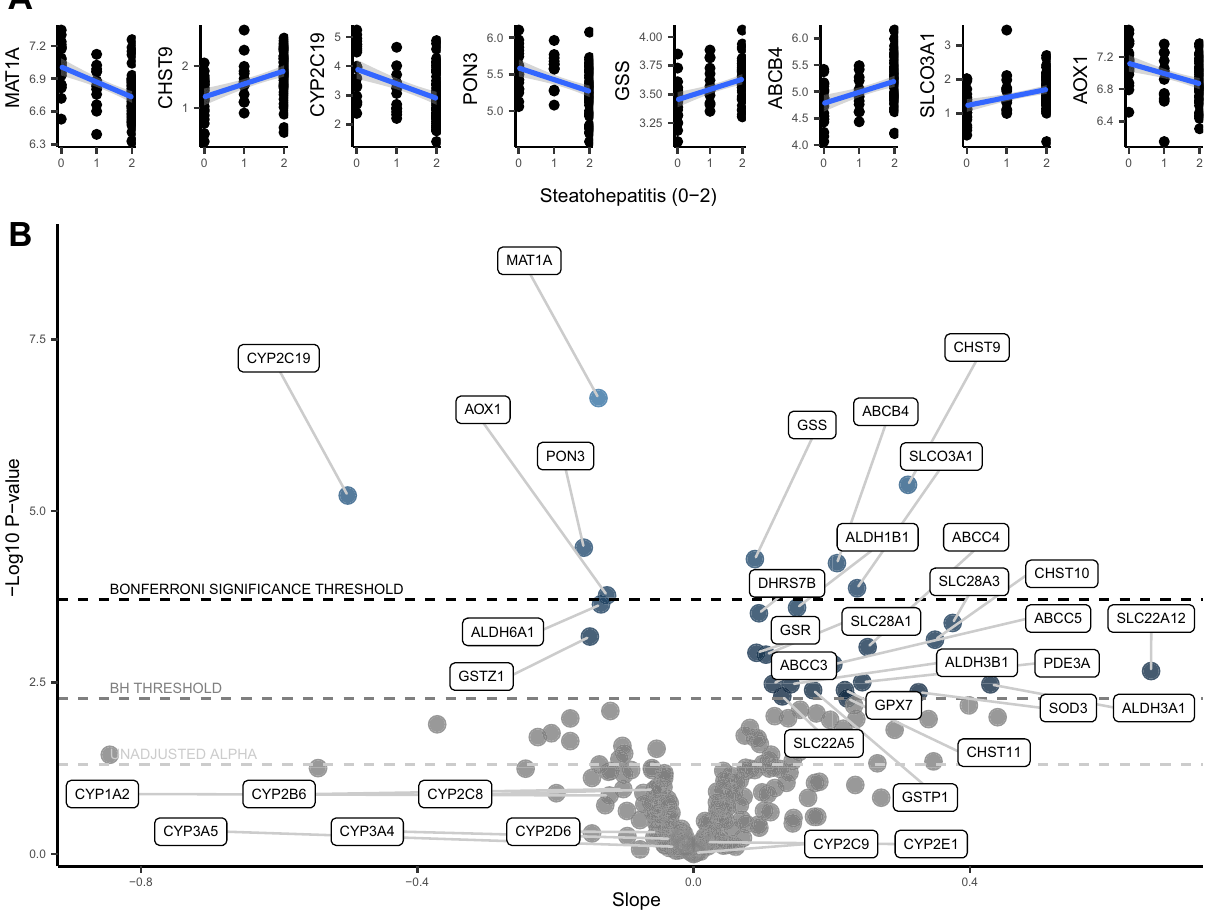
Fig. 4 | Regression results for steatohepatitis grade ( n =89). A Regression plots of the Bonferroni-adjusted signi fi cant correlations between fi brosis grade and pharmacogene mRNA expression. Linear trendlines were fi t (blue line) with 95% con fi dence interval region (grey). B Volcano plot showing the slopes and p values for the regressions between steatohepatitis grade and pharmacogene mRNA